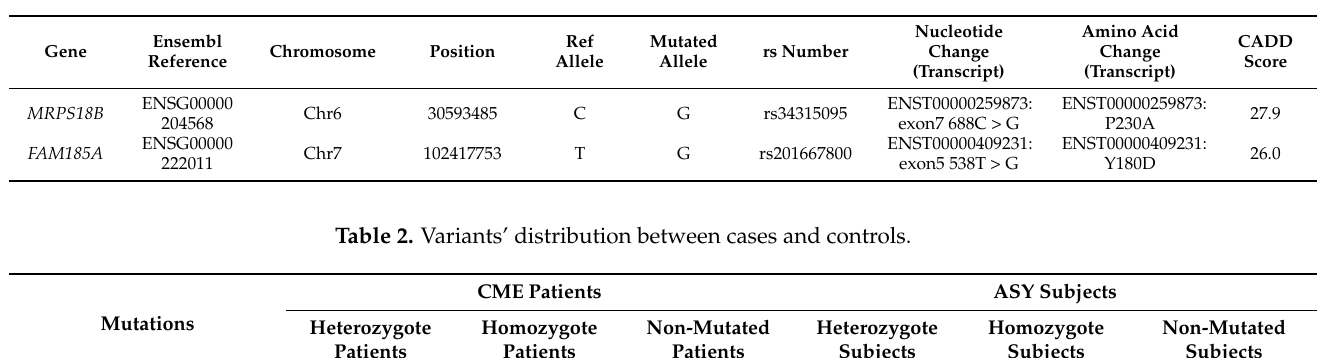
Figure 1. Schematic drawing describing the workflow of analysis. Table 1. List of associated variants.